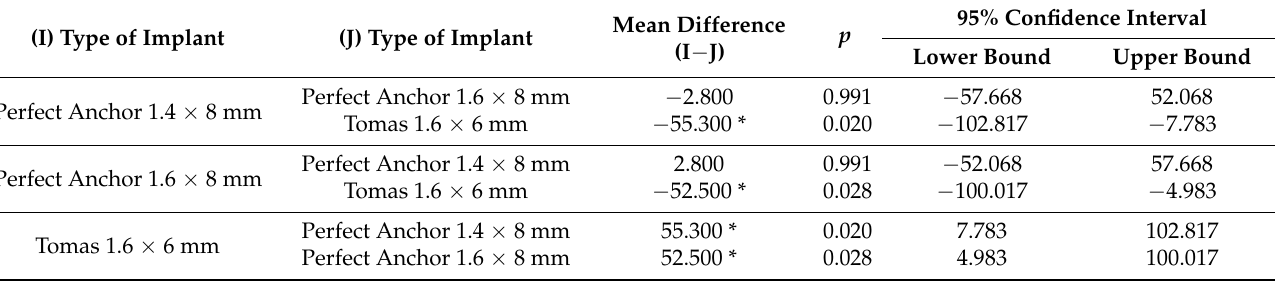
Table 3. Multiple post-hoc comparisons (Scheffe test)—type of implant.